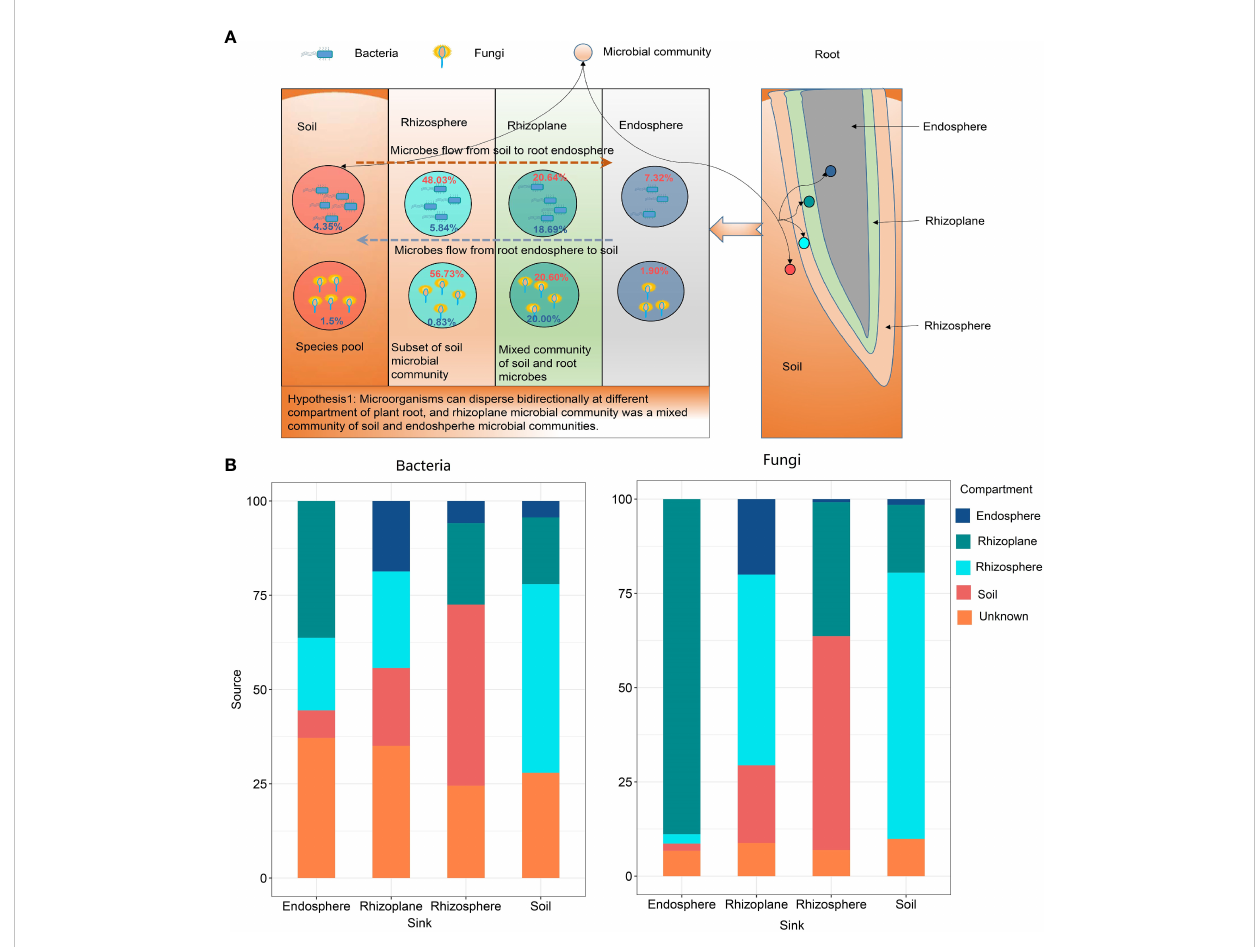
FIGURE 4 The potential sources of rubber tree root – associated bacterial and fungal communities of different compartments estimated by FEAST. (A) : The schematic diagram showing the bidirectional fl ow of microbes. Red numbers in circle indicate the percentage of microbes from soil, while blue numbers indicate microbes from the root endosphere; (B) : Bar plot illustrating the potential source of microbial communities in different